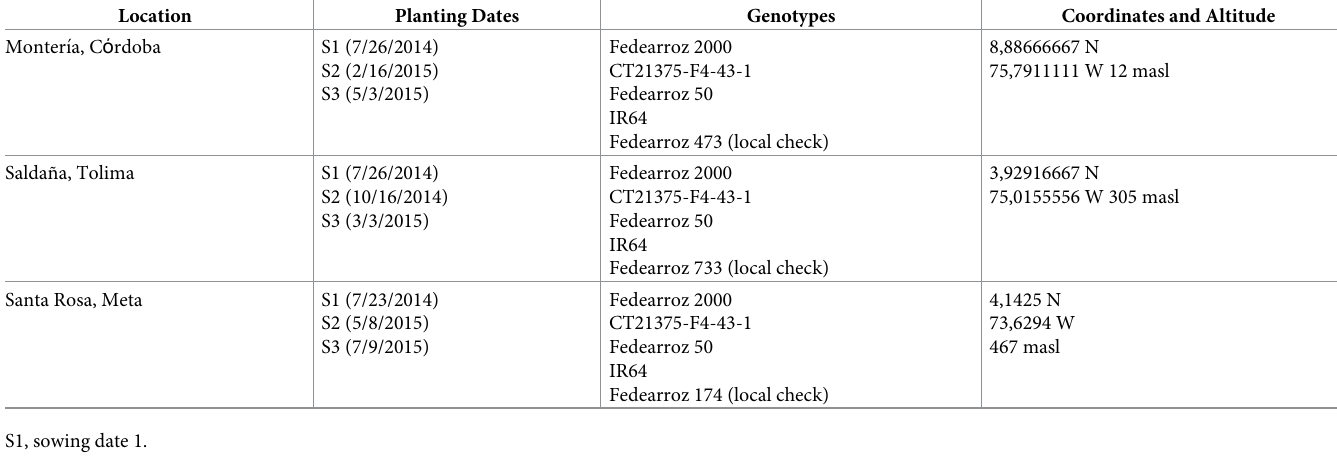
Table 1. Locations, planting dates, and genotypes used in this